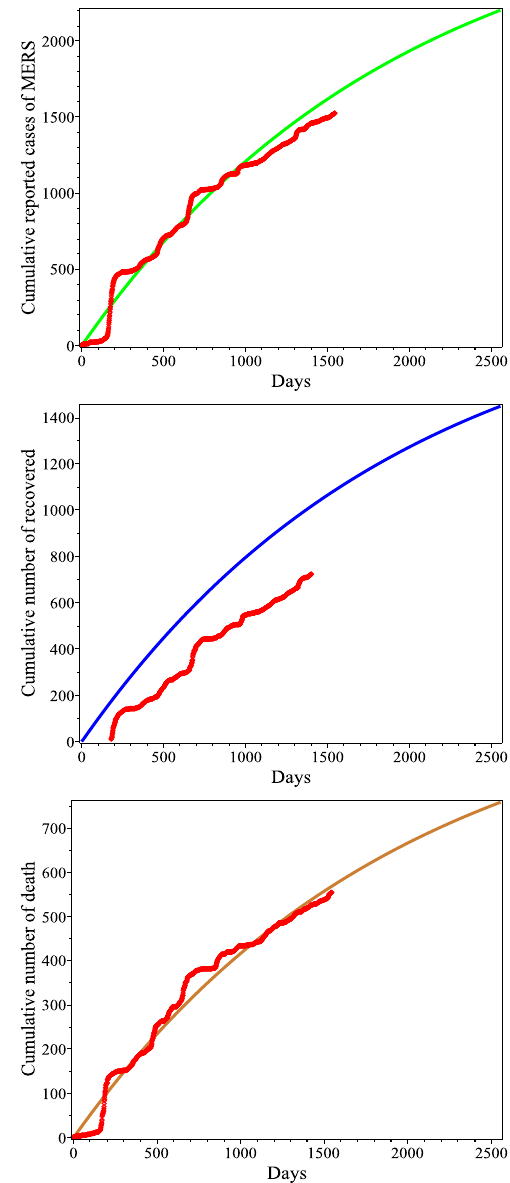
Fig. 3: Saudi baseline simulations of cumulative cases of MERS (T) - green curve; cumulative number of recovered (M) - blue curve; and cumulative number of death (B) - brown curve. The red dots are the field data. The run was for 2555 days ( ∼ 84